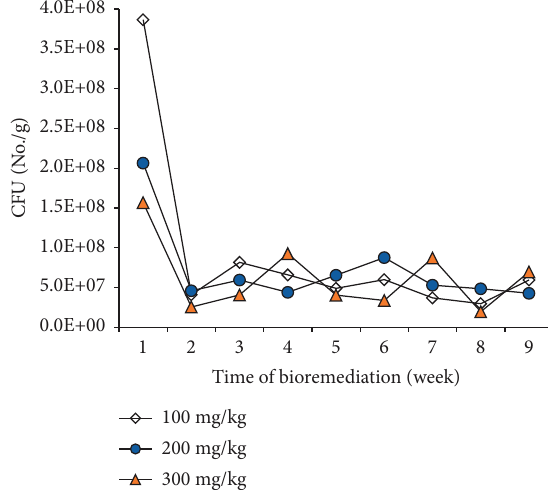
Figure 3: Microbial population trends in samples containing